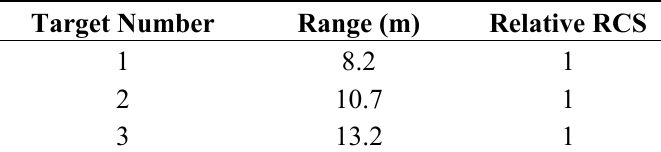
Table 5. Target Scenario 3.